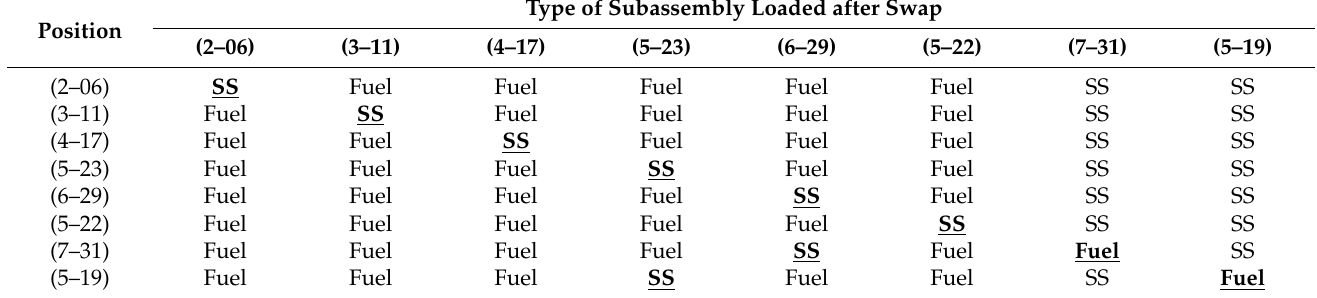
Table 8. Subassembly positions for swap reactivity test.